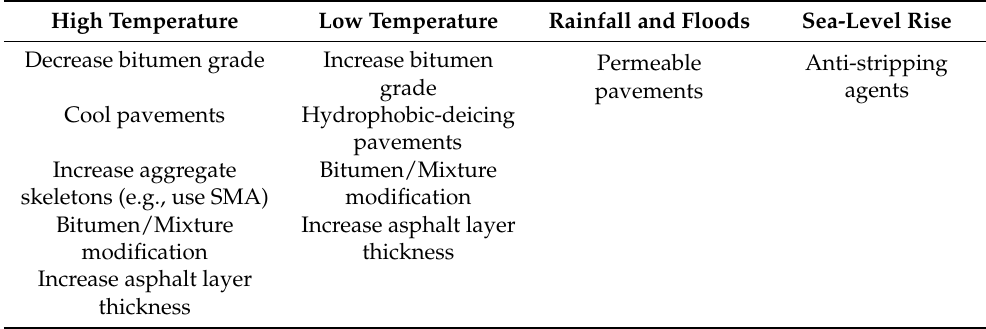
Table 1. Asphalt pavement’ solutions recommendations to mitigate different climate change